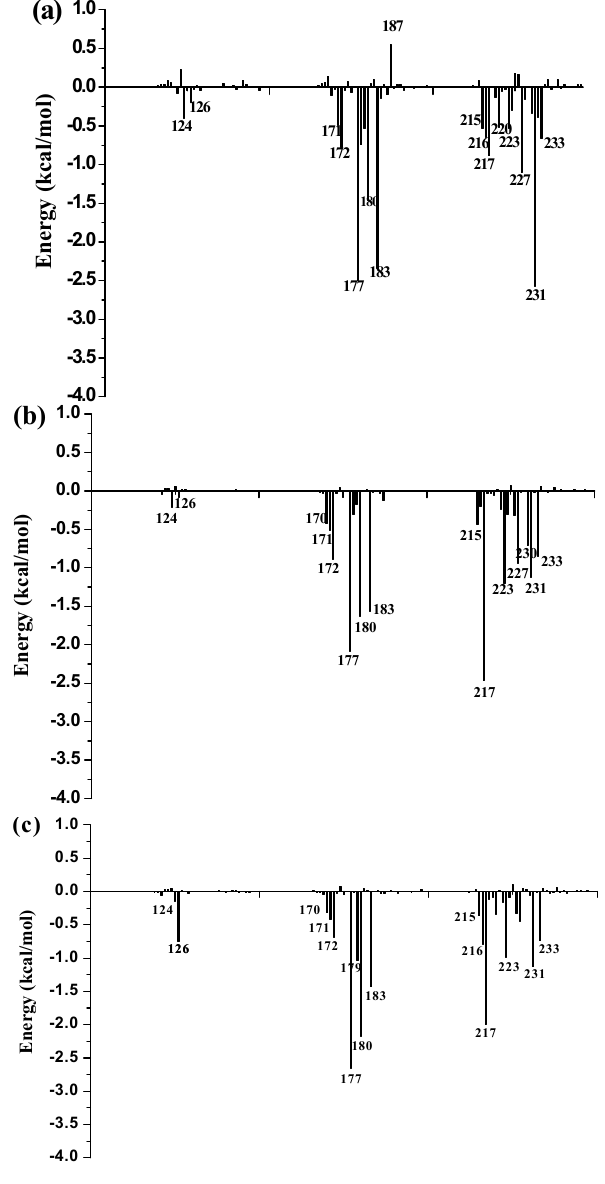
Figure 9. Per-residue binding free energy decomposition of: ( a ) 11 β -HSD1- 1 , ( b ) 11 β -HSD1- 11 , ( c ) 11 β -HSD1- 14 .